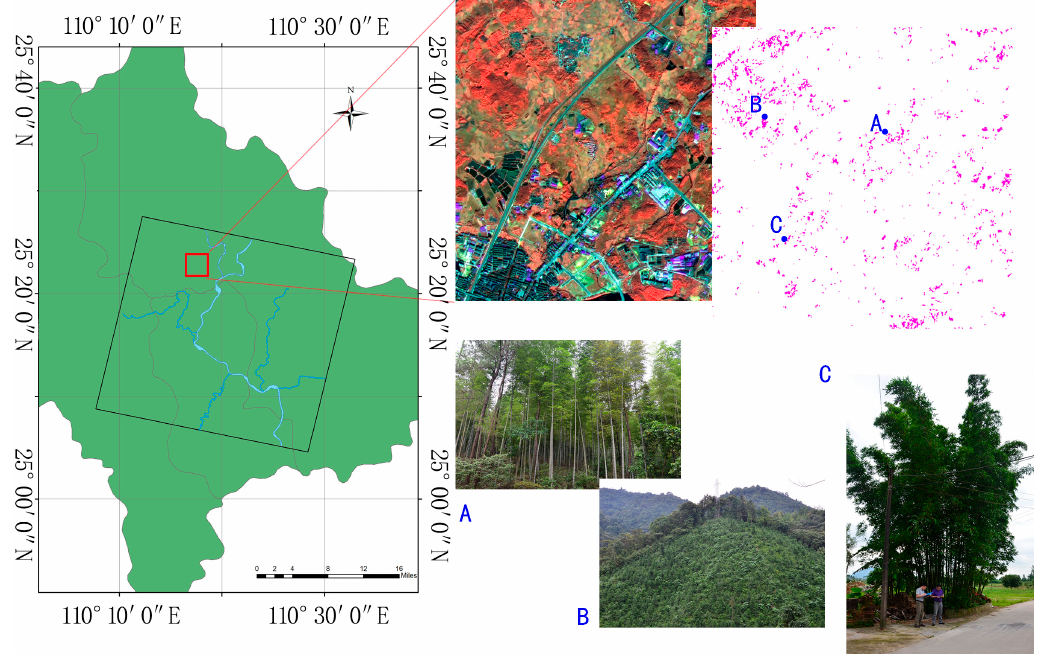
Figure 8. Photos of the bamboo forest at specified locations. Illustrations ( A ), ( B ) and ( C ) are the photographs of locations A, B and C. Figure 7. The fusion result based on BEMD (increase using panchromatic images) ( a ) The fusion result based on BEMD and Gram-Schmidt transform, which includes three types of images (panchromatic,